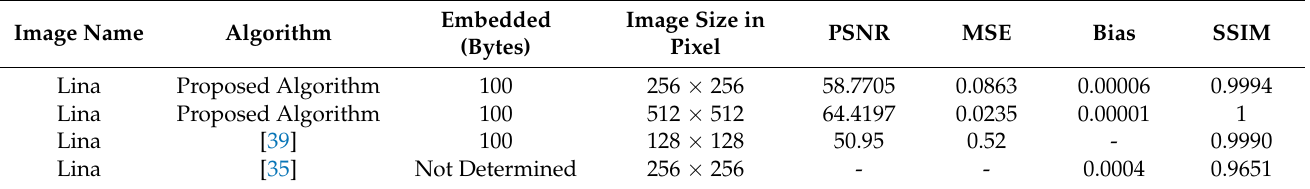
Table 2. Comparison of the proposed algorithm with [35,39] with respect to embedding 2,000 Bytes.